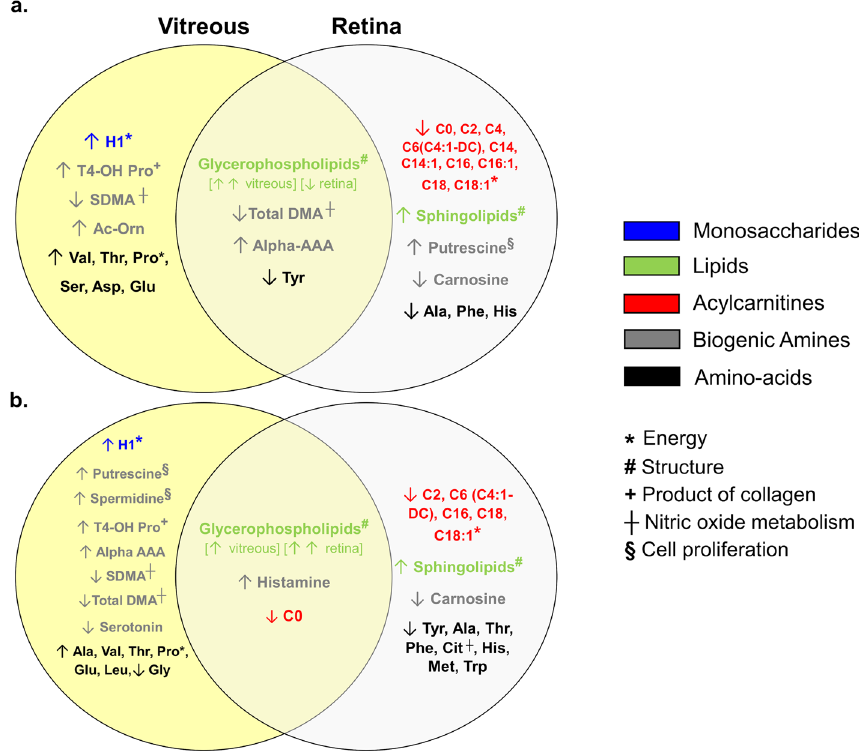
Figure 8. Venn diagrams summarizing metabolomic changes in the vitreous and retina of recovering FDEP ( a ) and control ( b ) eyes in animals exposed to BEW light compared to SW light. Compared to eyes reared under SW light, the metabolomic profiles within the FDEP and control eyes reared under BEW, involved an increase in vitreal H1, a reduction in retinal acylcarnitines, as well as increases in glycerophospholipids and sphingolipids in the vitreous and retina, respectively. Recovering FDEP eyes and control eyes exposed to BEW light also exhibited changes in biogenic amines (e.g., total and symmetric dimethylarginine (total DMA and SDMA), putrescine, spermidine, alpha aminodipic acid (alpha-AAA) and serotonin) and amino acids (e.g., alanine, valine, threonine, histidine and tyrosine) in the vitreous and retina. Alpha-AAA alpha-aminodipic acid, Ala alanine, Asp aspartate, C0 carnitine, C2 acetylcarnitine, C4 butyrylcarnitine, C6 hexanoylcarnitine, C6 ( C4:1-DC ) hexanoylcarnitine (fumarylcarnitine), C14 tetradecanoylcarnitine, C14:1 tetradecenoylcarnitine, C16 hexadecanoylcarnitine, C18 octadecanoylcarnitine, C18-1 octadecenoylcarnitine, Cit citrulline, Glu glutamate, H1 sum of hexoses (including glucose), His histidine, Iso isoleucine, Lys lysine, Met methionine, Phe phenylalanine, Pro proline, SDMA symmetric dimethylarginine, t4-OH Pro trans -4-hydroxyproline, Thr threonine, Total DMA total dimethylarginine, Trp tryptophan, Tyr tyrosine, Val